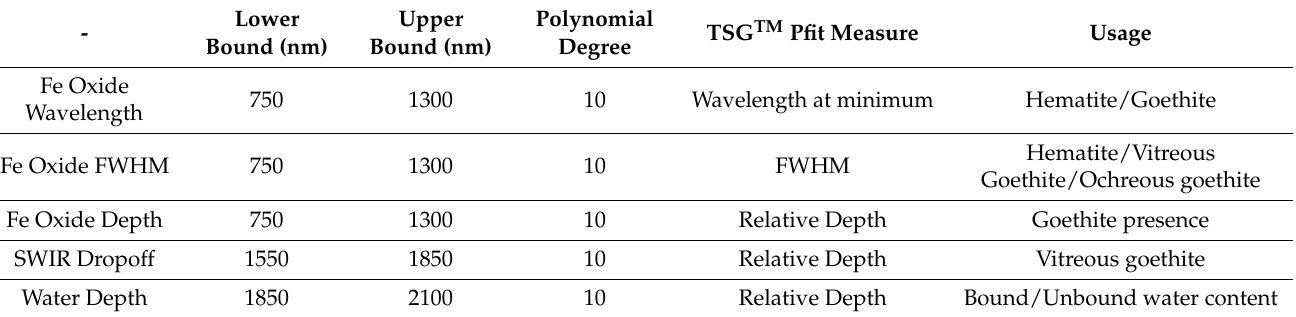
Table 1. The spectral metrics used in this study. The calculation of the metrics was performed in the CSIRO-developed TSG TM software. The last column “Usage” shows the general purpose of the